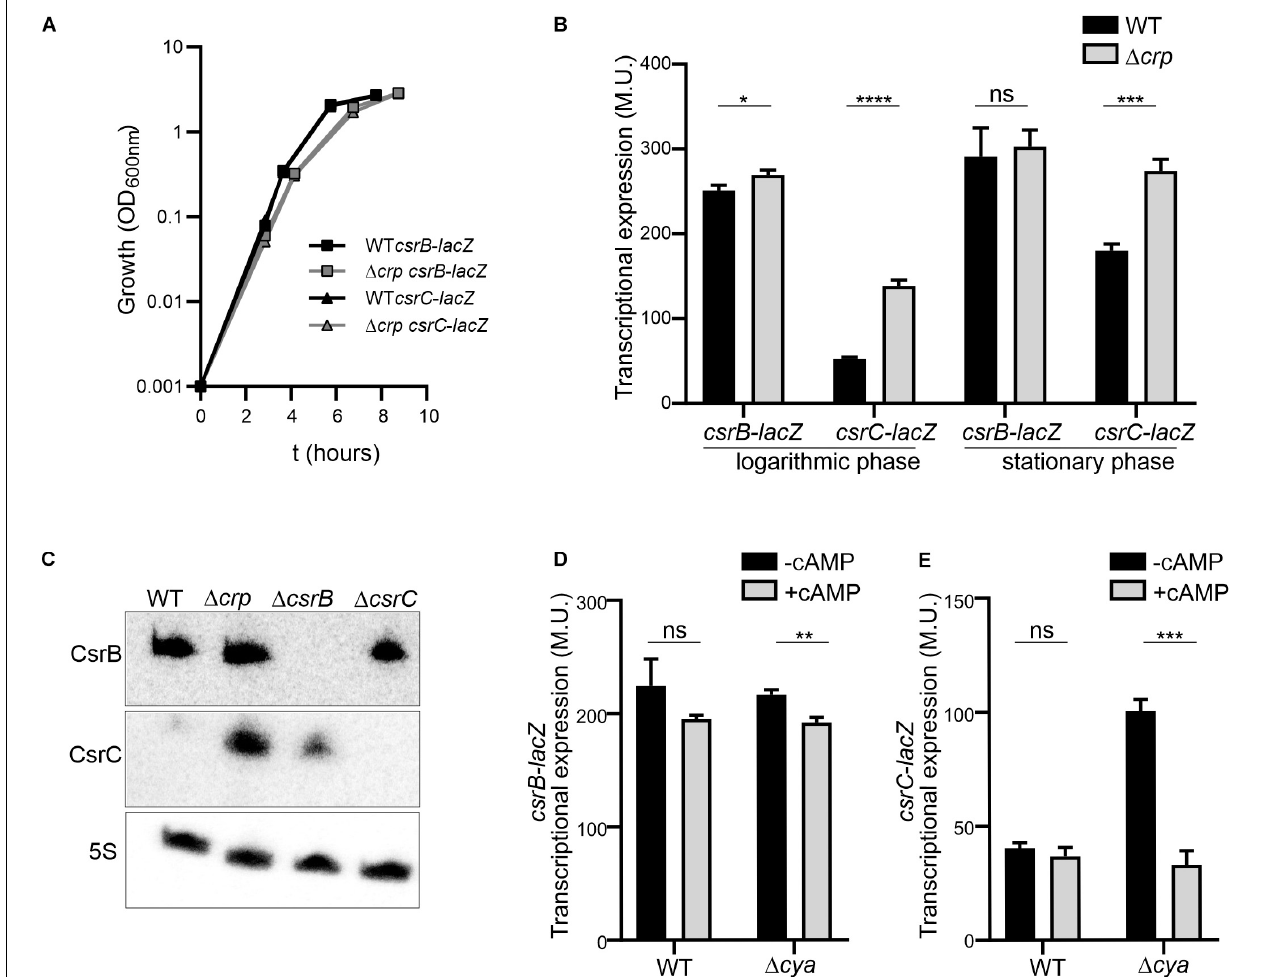
FIGURE 1 | The expression of csrC is repressed at the logarithmic growth phase in a CRP-cAMP mediated manner. (A) Growth curve in LB at 37 ◦ C of Salmonella SV5015 strain (WT) and its isogenic (cid:49) crp mutant, carrying either a plasmid fusion of csrB-lacZ or csrC-lacZ . (B) Transcriptional expression of csrB and csrC . Samples from cultures in A were taken at either an OD 600 nm of 0.4 or an OD 600 nm of 2.0 for determination of the β -galactosidase activity in Miller units (M.U.). (C) Northern blot analyses of the csrB and csrC transcripts. Total RNA samples from cultures of WT (SV5015) and its derivatives (cid:49) crp , (cid:49) csrB, and (cid:49) csrC grown in LB up to an OD 600 nm of 0.4 were analyzed. Detection of the 5S transcript was used as a control. Transcriptional expression of csrB (D) and csrC (E) in the cya mutant strain and chemical complementation. Cultures of WT, (cid:49) crp and (cid:49) cya derivatives were grown in LB either in the absence or in the presence of cAMP (5 mM) at 37 ◦ C up to logarithmic phase (OD 600 nm of 0.4) and samples were taken for β -galactosidase measurement. In B, C and D; β -galactosidase activity was determined for three independent cultures, average and standard deviation are presented. * p < 0.05; ** p < 0.01; *** p < 0.001; **** p < 0.0001; ns, not